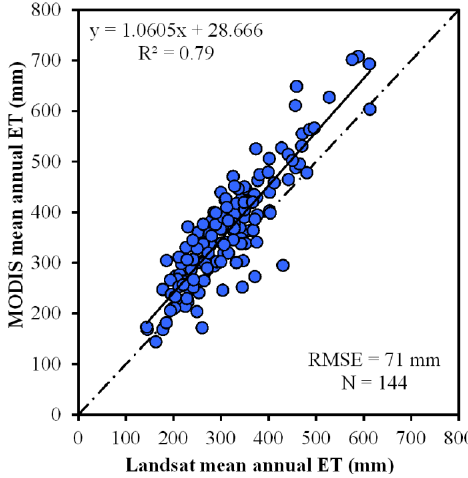
Figure 10. Comparison of mean annual evapotranspiration of sub-basins (HUC8) using Landsat and MODIS images.